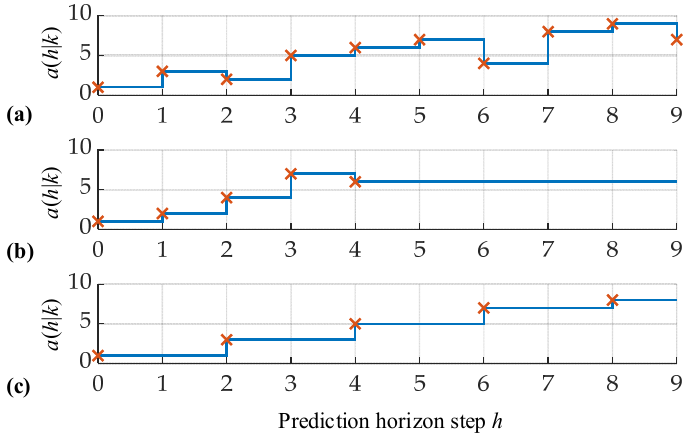
Figure 3. Illustration of full control horizon ( a ), limited control horizon ( b ), and move-blocking strategies ( c ).